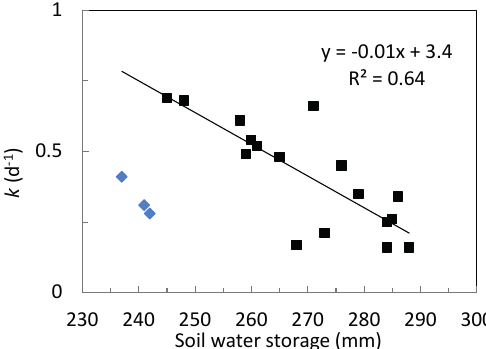
Figure 8. Recession constant ( k ) and soil water storage at the start of the recession period for individual events. The choice of events is explained in the text, as are the three blue points.